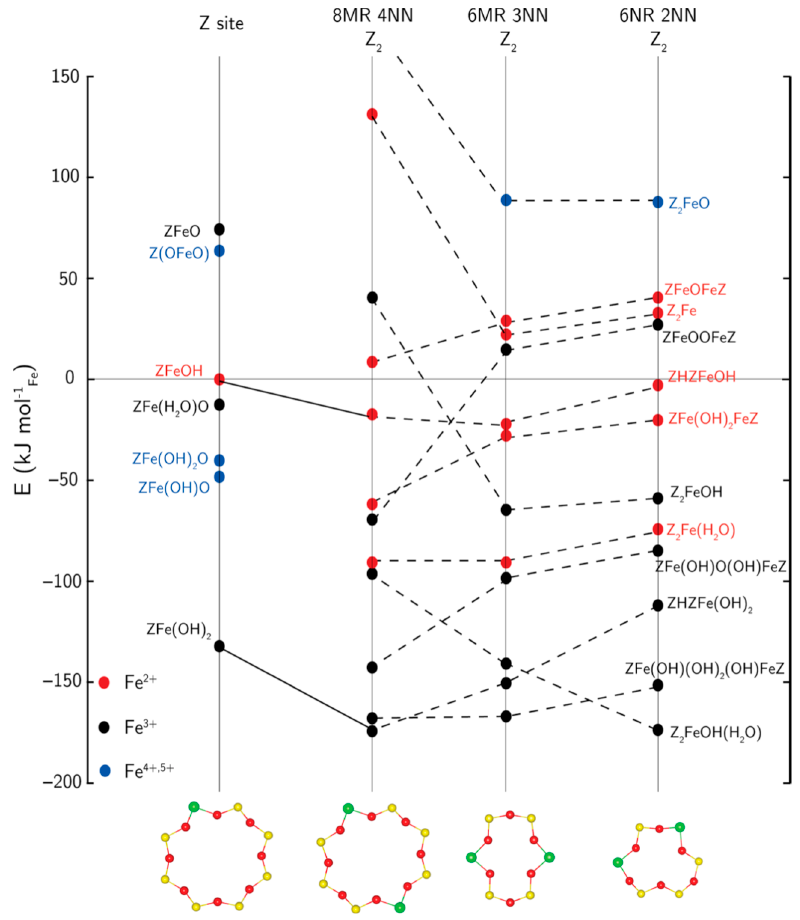
Figure 8. Relative energies of Fe species calculated using the Heyd-Scuseria-Ernzerhof (HSE) method at isolated (left) and paired (Z 2 ) sites, referenced to an isolated ZFeOH. Colors indicate the Fe formal oxidation state. Solid lines connect monomeric [Fe(OH) 2 ] + and [Fe(OH)] + species at an isolated Al site and 8MR 4NN Z 2 sites. Dashed lines connect analogous species among Z 2 sites. Reprinted with permission from [35]. Copyright © 2018 American Chemical Society.